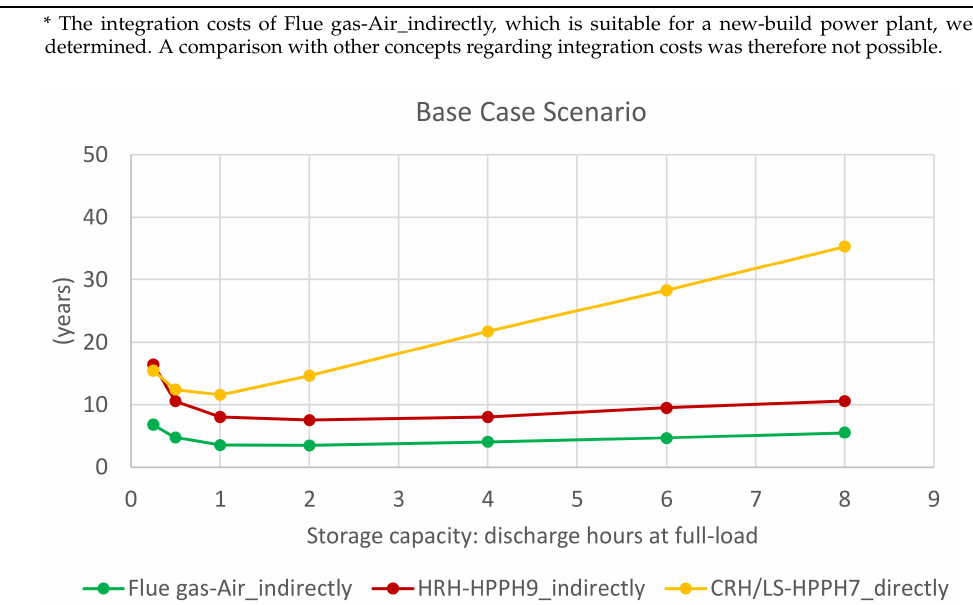
Figure 30. Payback period in years (payback period, not discounted). The respective payback periods of the concepts were calculated. For a comparison of the economic efficiency of the concepts, both the investment costs (without integration costs) were considered in individual cases (Table 12), and the total costs were compared. For the calculation of the dynamic payback period, a discount factor of 4% was assumed as the lower value and a discount factor of 8% as the upper value. If only the investment costs (without integration costs) are considered, Flue gas-Air_indirectly is the most economical concept, closely followed by HRH-HPPH9_indirectly. CRH/LS-HPPH7_directly is the least economical